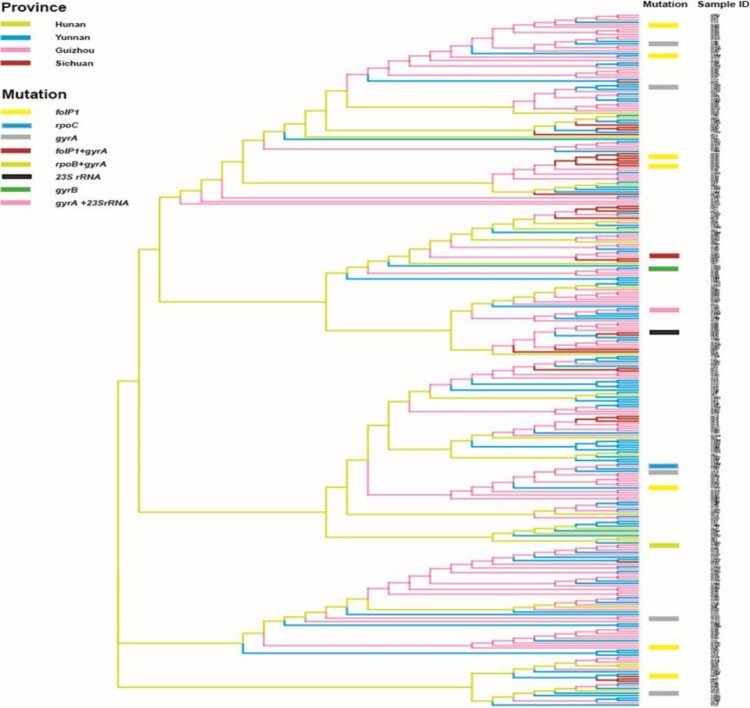
Phylogeny of wild-type and mutated strains from all four provinces. Genetic clustering pattern based on variable number tandem repeats for all wild-type and mutated strains (290 strains) of the counties of studied provinces. All branches are highlighted with four colours indicate four provinces. Mutated strains are represented with coloured rectangle columns. Each sample information is represented with three letters, where the 1st, 2nd, and 3rd letter specifies province, city, and county respectively.